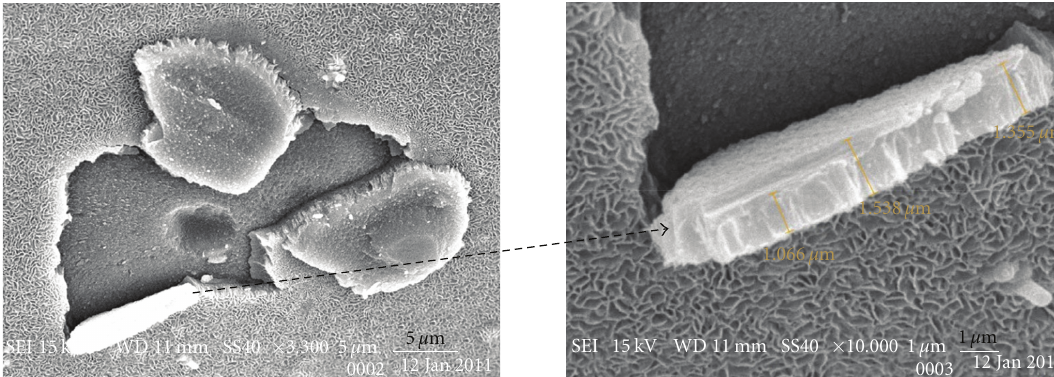
Figure 5: The SEM image of the surface of the powdered glass leached in MgCl 2 solution at 90 ◦ C for 64 days.